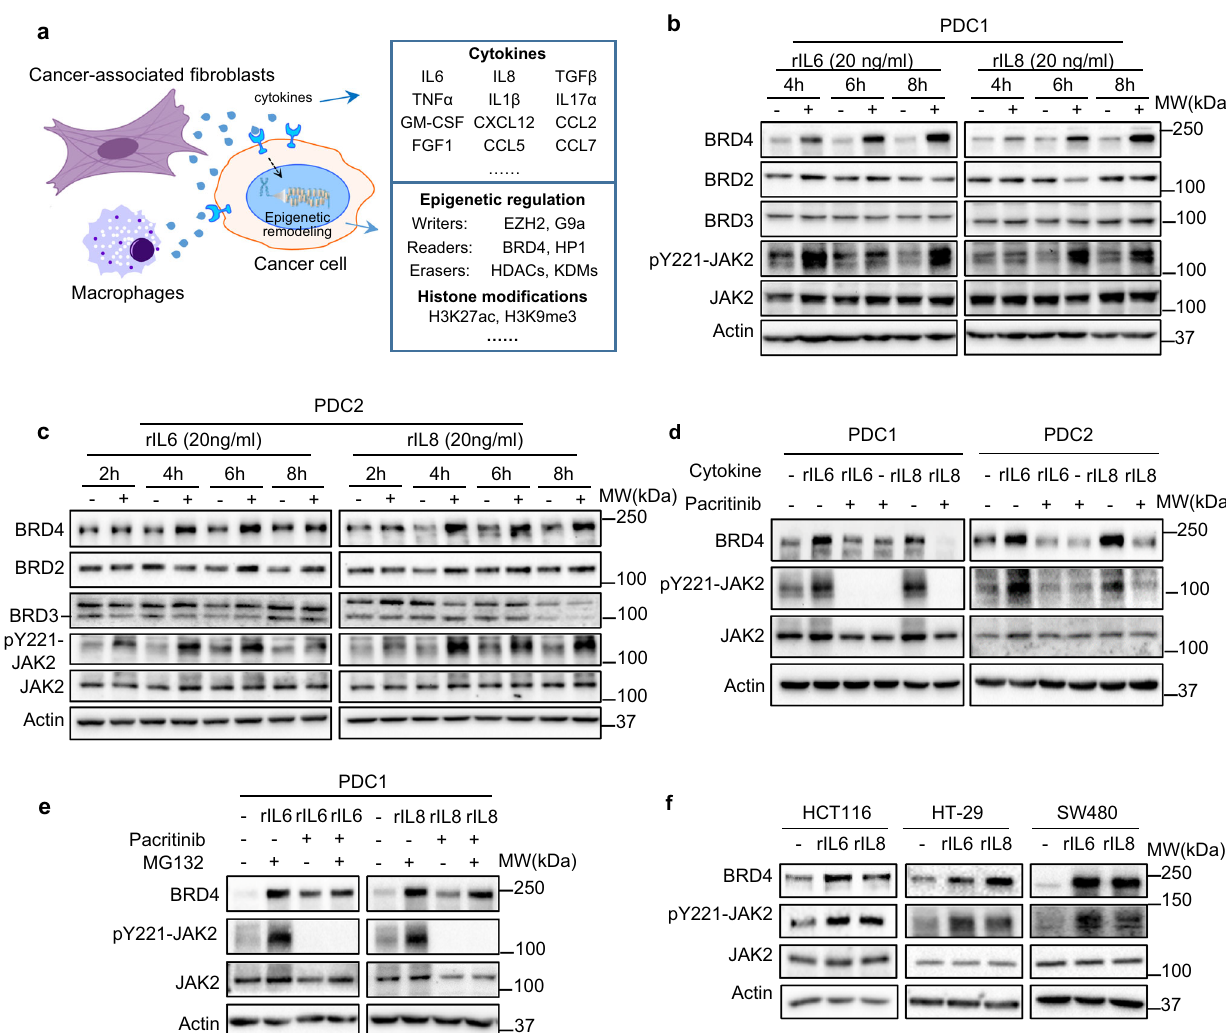
Fig. 1 IL6 and IL8 induce BRD4 protein expression in CRC. a Illustration depicting a screening strategy to investigate the tumor microenvironment-derived cytokines and their proposed function on epigenetic remodeling in CRC. b , c Representative western blot analysis of indicated proteins in patient-derived cancer cells PDC1 ( b , n = 3) and PDC2 ( c , n = 2) after treatment with 20 ng/ml rIL6 or 20 ng/ml rIL8 for indicated time. d Representative western blot analysis ( n = 2) of indicated proteins in patient-derived cancer cells treated with/without 20 ng/ml rIL6 (20 ng/ml), 20 ng/ml rIL8, or 2.5 μ M pacritinib. e Representative western blot analysis ( n = 2) of indicated proteins in patient-derived cancer cells treated with/without 20 ng/ml rIL6, 20 ng/ml rIL8, 2.5 μ M pacritinib, or 20 μ M MG132. f Representative western blot analysis ( n = 2) of indicated proteins in colon cancer cell lines (HCT116, HT-29, SW480) treated with 5 ng/ml rIL6 or